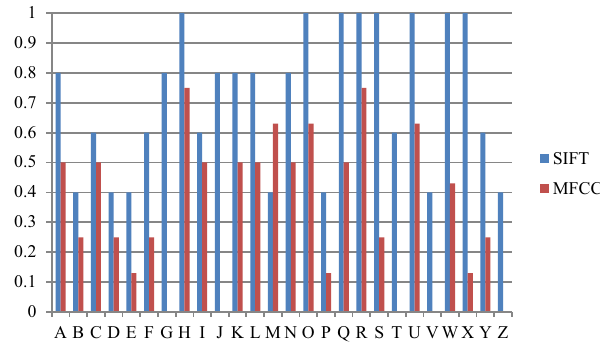
Fig. 8 Correct classification rate of LNBNN with MFCC and SIFT features on the ISOLET database